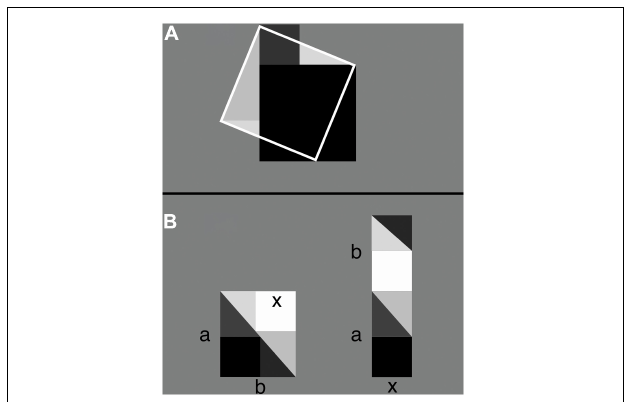
FIGURE 2 | Abstract algebraic expressions as physical geometric puzzles [adapted from Wang (2009)]. (A) Let the areas of, respectively, the dark-gray, black, and white-framed squares be a 2 , b 2 , and c 2 . By placing the triangular parts of the dark-colored squares that fall outside the white frame onto the light-colored triangles inside it, the dark-colored squares exactly cover the area of the white-framed square. That is, a 2 + b 2 = c 2 (the Pythagorean theorem). (B) On the left, a dark square is shown that just fits inside a dark-colored triangle. Task: Find the length x of one of the sides of the dark square. Solution: Next to the triangle and square (shown in dark colors) add a copy of it (shown in light colors) so that a rectangle emerges with area ab . Rearrange the pieces (shown on the right) so that another rectangle emerges with area ( a + b ) x . Compare the rectangle on the left with the one on the right and note that ab = ( a + b ) x and thus that x = ab /( a + b